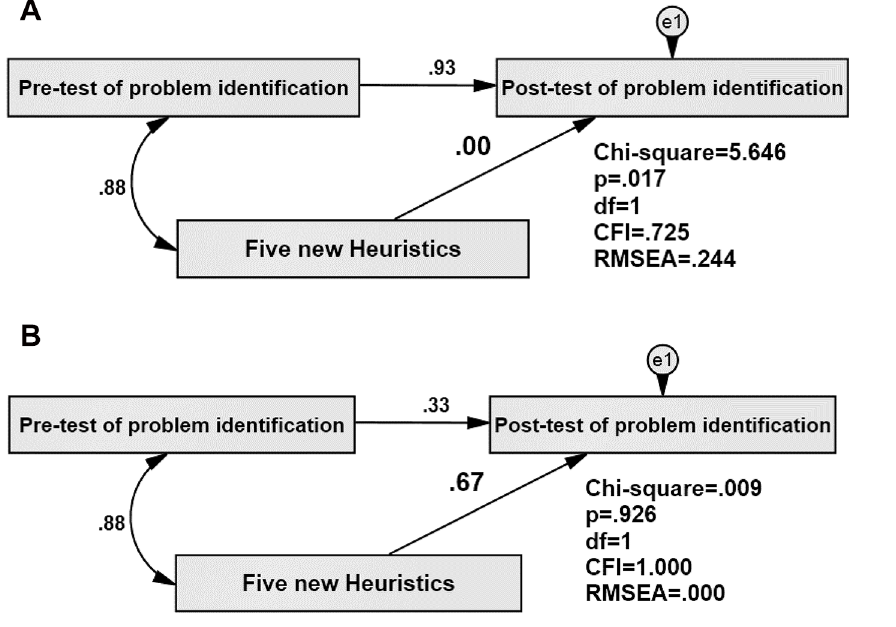
Fig 11. Analysed model when a =